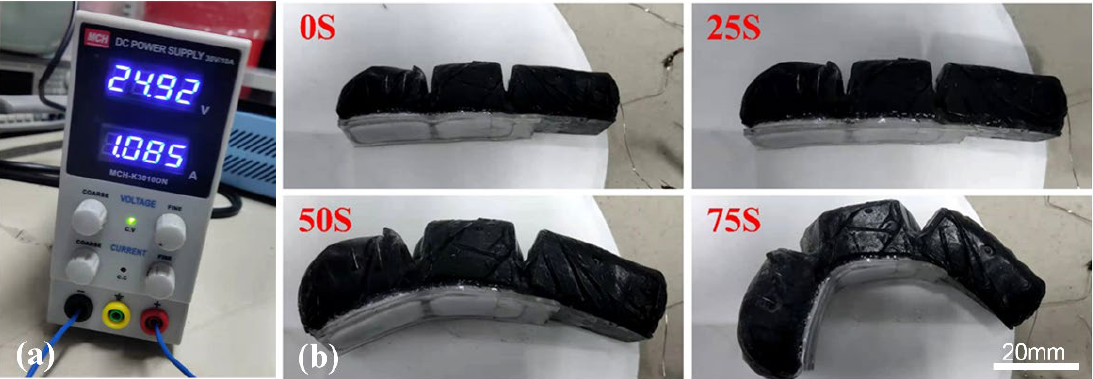
Figure 6. Electro–thermal driving test of the artificial finger. ( a ) DC power indicating the applied voltage and current for heating the artificial finger. ( b ) Captured photos recorded during the bending process of artificial finger in 75 s.